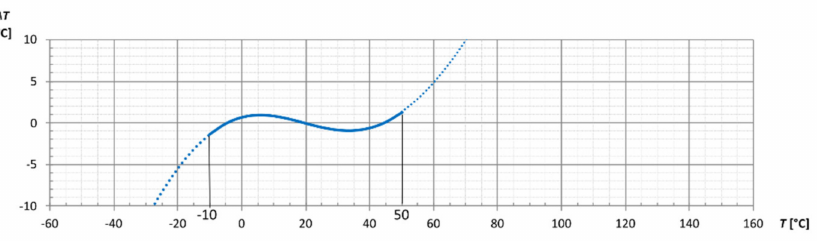
Figure 9. Temperature error for linear